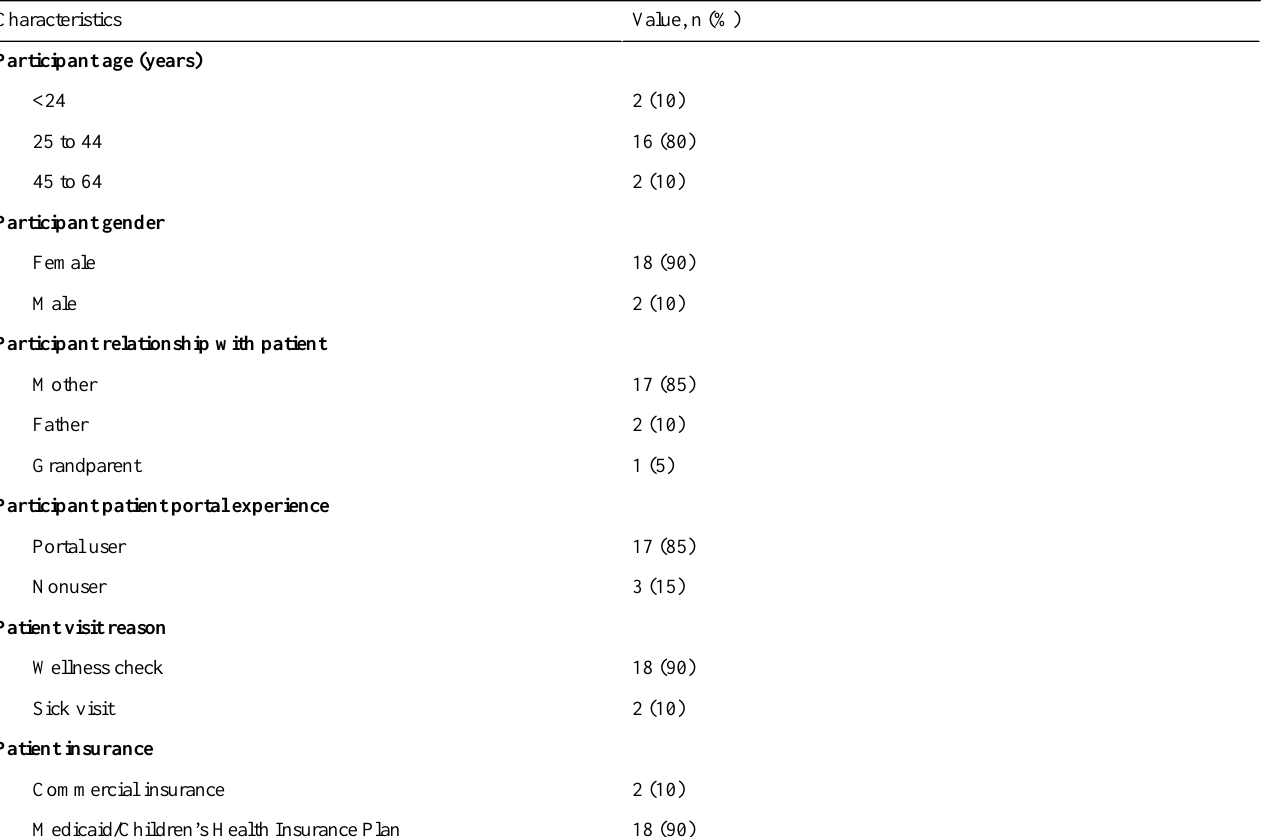
Table 1. Participant demographics.